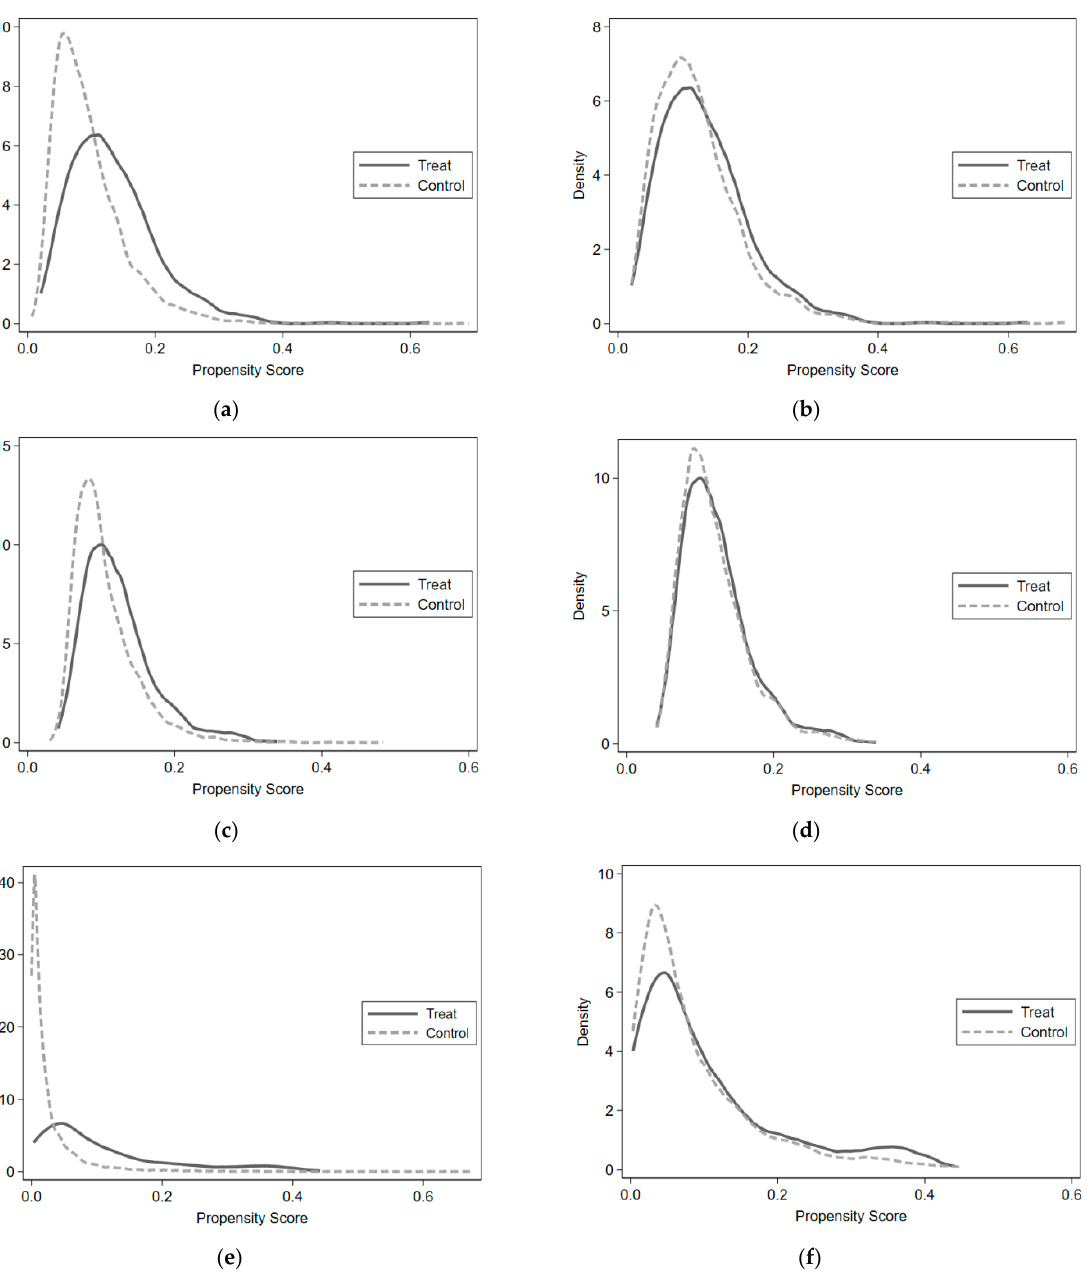
Figure 1. Kernel density functions of the treatment and control groups before matching and after k-nearest neighbor matching (k = 4). ( a ) Married-Single Group (Before Matching); ( b ) Married-Single Group (After K-nearest Neighbor Matching (k = 4) ); ( c ) Married-Divorced/Separated Group (Before Matching); ( d ) Married-Divorced/Separated Group (After K-nearest Neighbor Matching (k = 4)); ( e ) Married-Widowed Group (Before Matching); ( f ) Married-Widowed Group (After K-nearest Neighbor Matching (k = 4)).